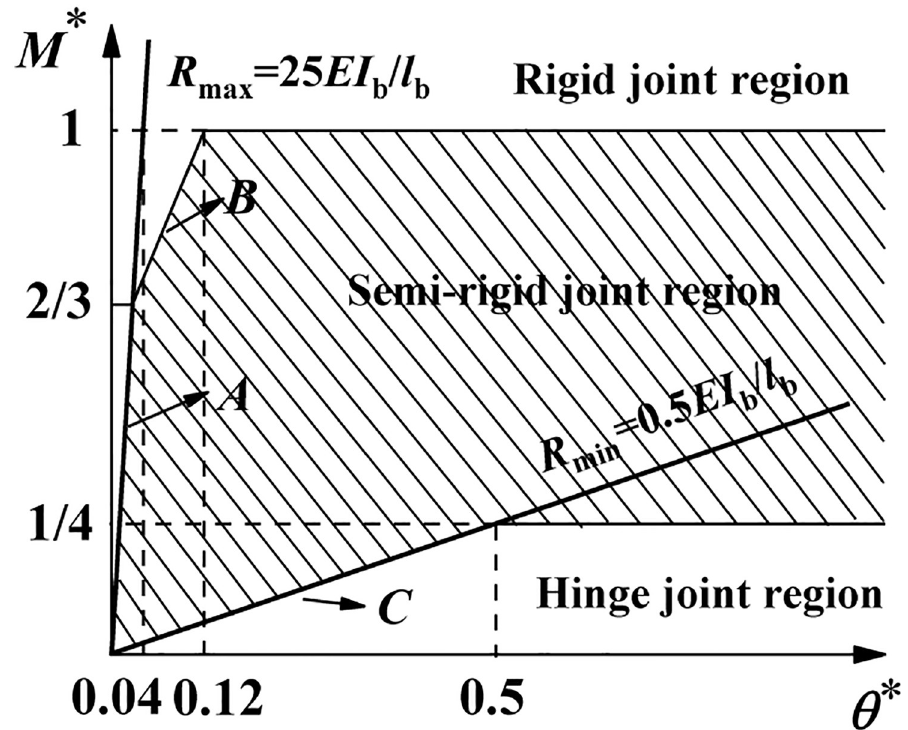
Fig 12. Diagram of initial bending stiffness of socket-type joint.